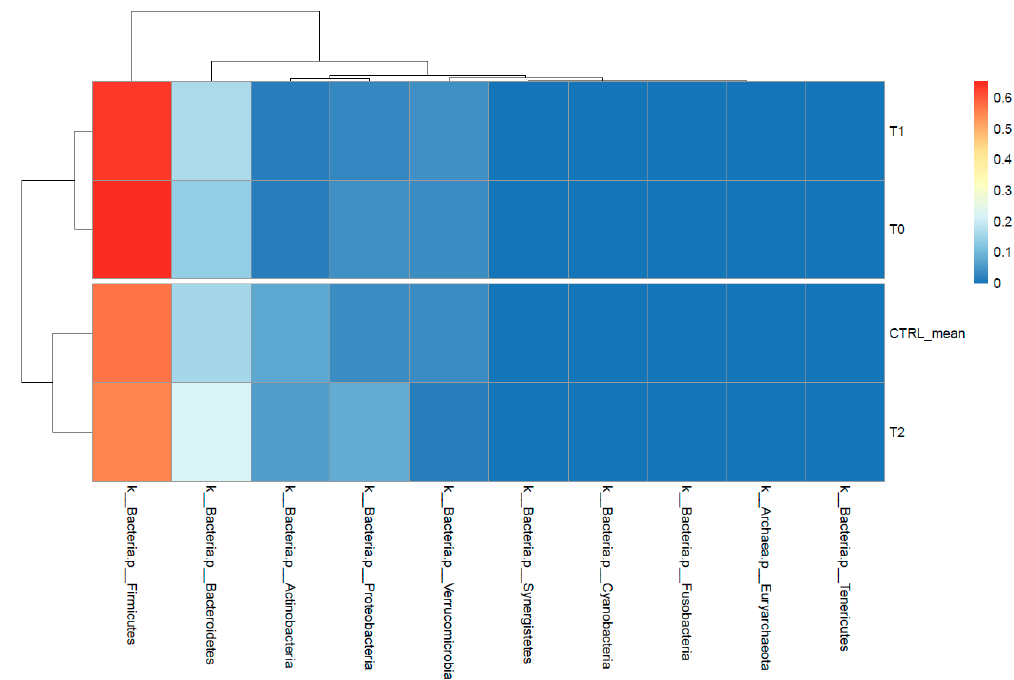
Figure 3. Heatmap with hierarchical clustering based on phyla (L2) abundances. The colors in the heatmap refer to the phylum’s abundance, according to the color scale on the right.